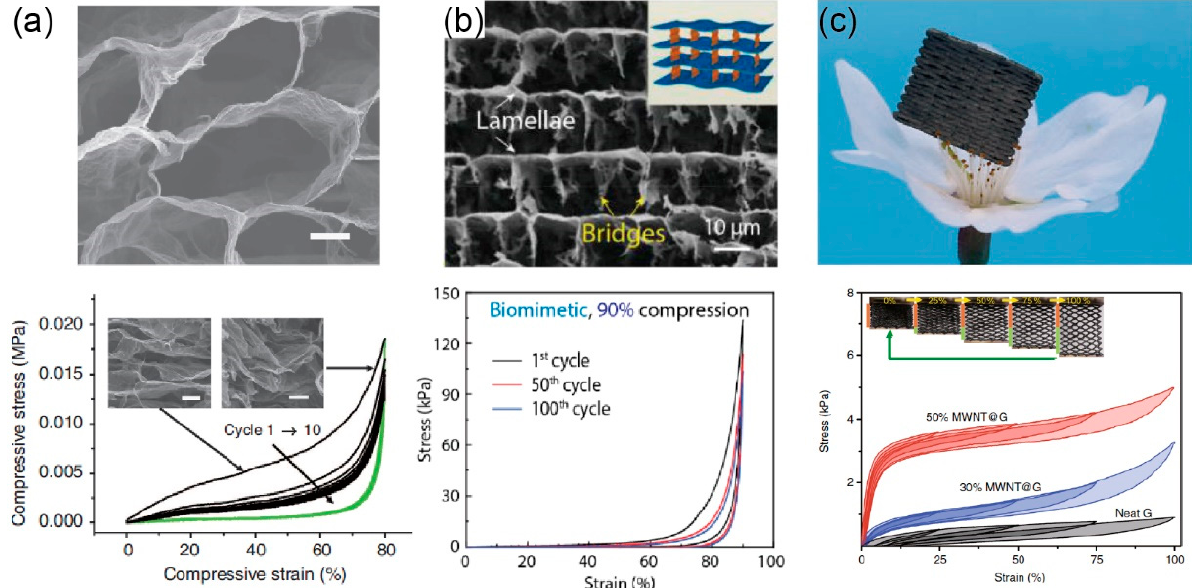
Figure 13. Graphene aerogels (GAs). ( a ) Regular microstructures of GAs resultant from template directing method. Reprinted with permission from [163]. ( b ) Bio-mimicking lamellar GAs with exceptional strength and mechanical resilience. Reprinted with permission from [165]. ( c ) 3D printed stretchable GAs. Reprinted with permission from [164].